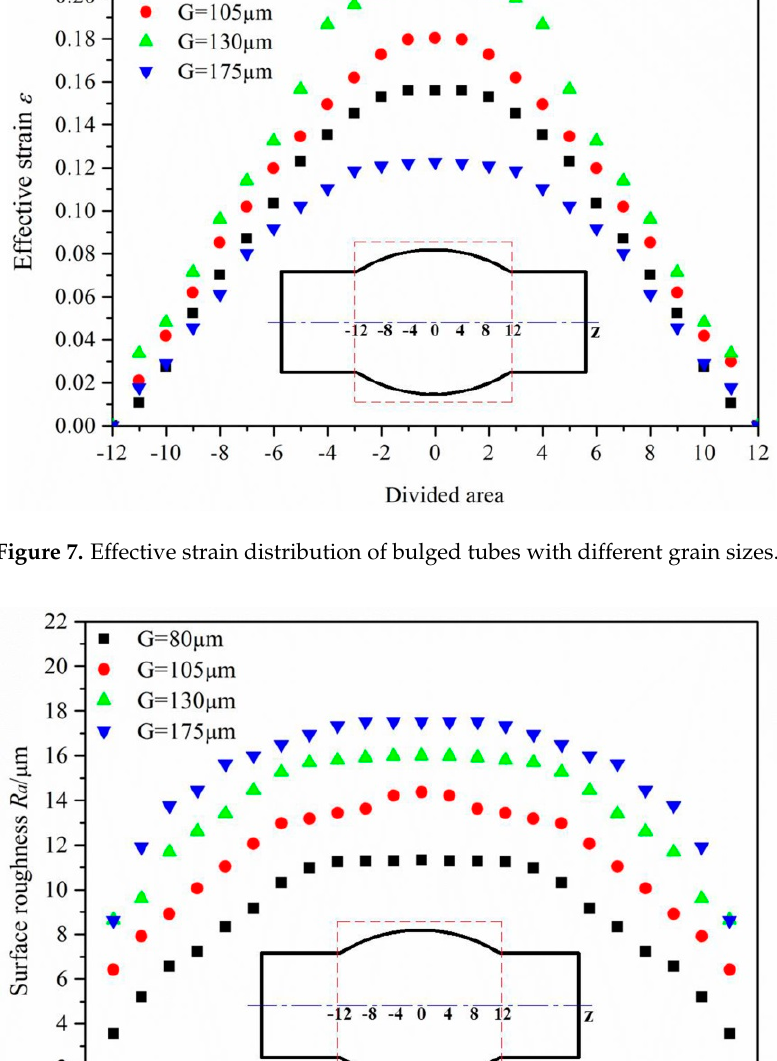
Figure 9. Relationship between surface roughness and effective strain of bulged tubes with different grain sizes.